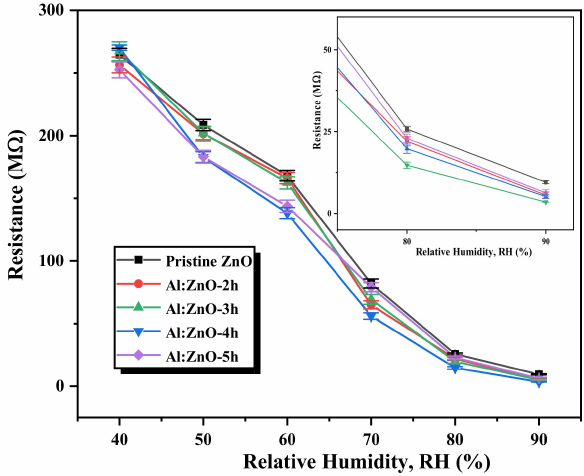
Figure 13. Variation in the resistance of the pristine ZnO and Al:ZnO nanostructured-based flexible humidity sensors with varying doping immersion time at various humidity levels at 25 ◦ C (inset shows the magnified image at 80 %RH and 90 %RH).